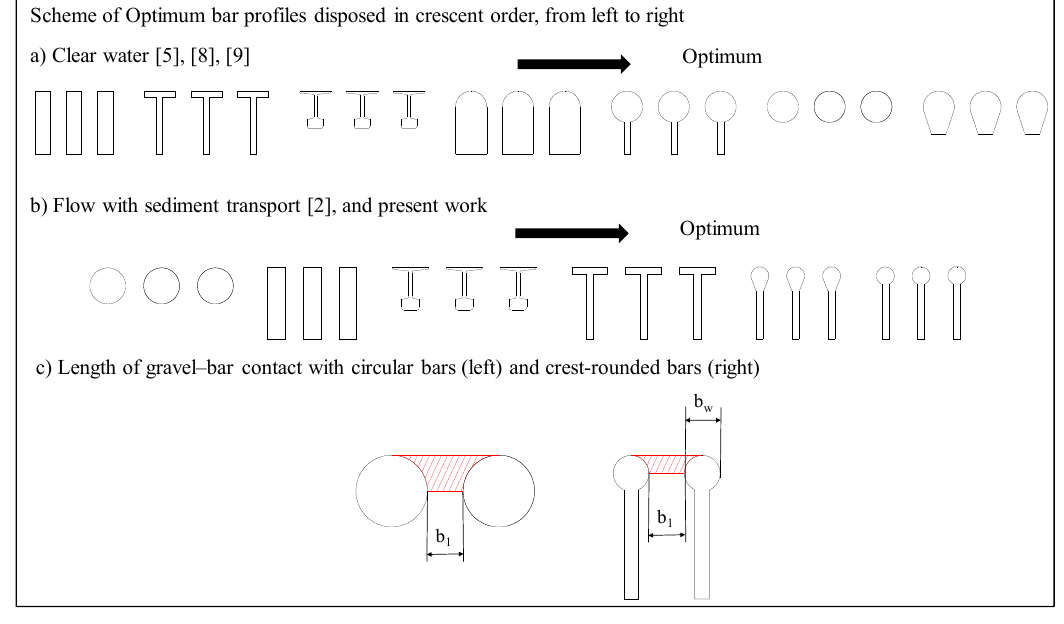
Figure 3. Scheme of optimum bar profiles: ( a ) clear water flow; ( b ) flow with sediments; ( c ) Figure